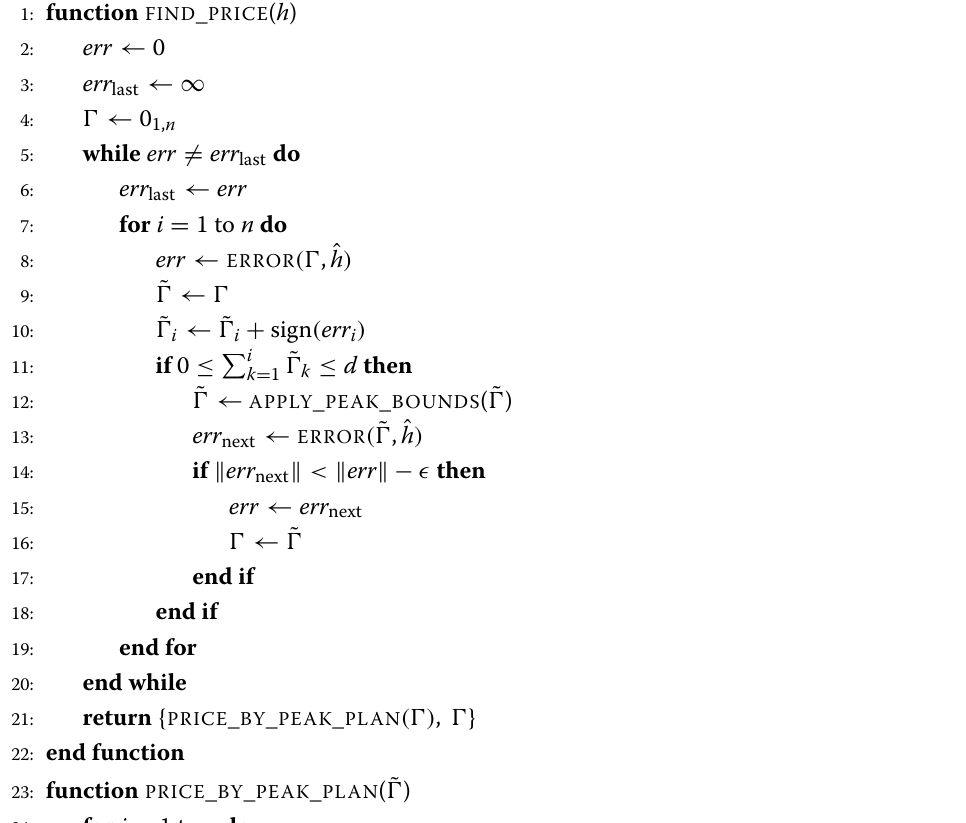
Algorithm 1 τ -Price